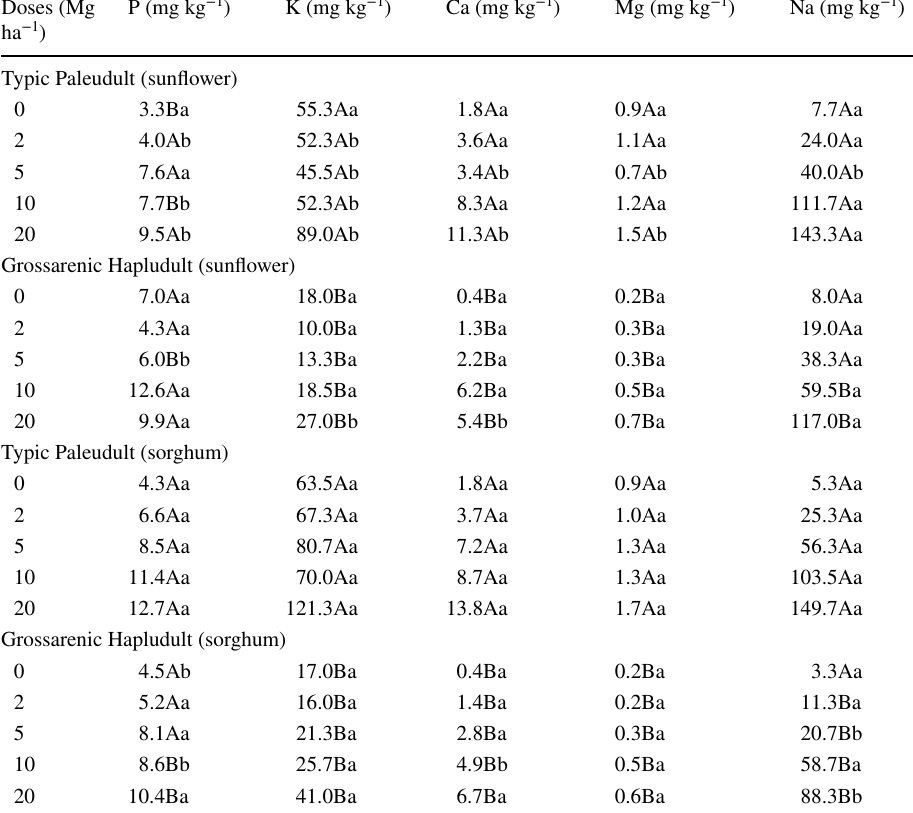
concentrations of macro elements on Typic Paleudult and Grossarenic Hapludult soils with sunflower and sorghum cultivation under the amendment of industrial